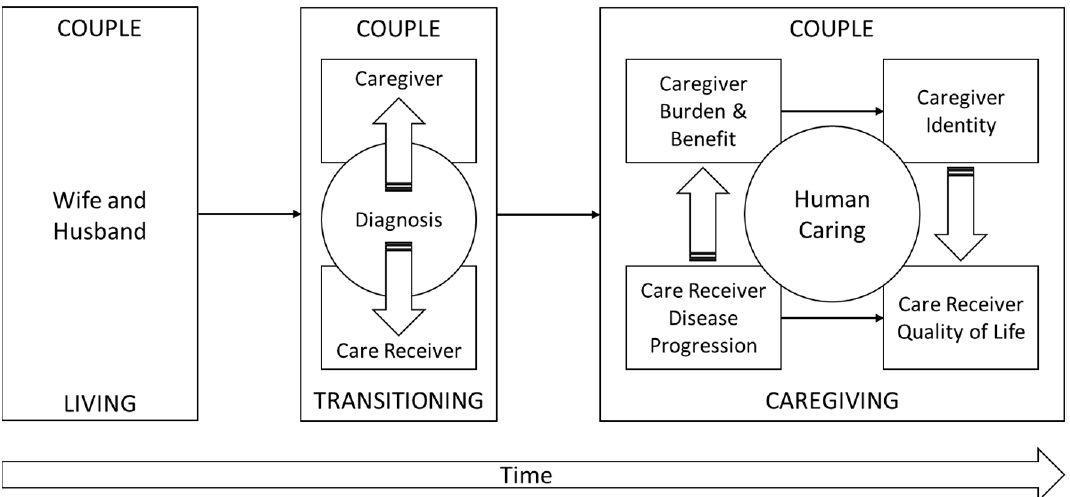
Figure 1. Conceptual Framework for Caregiver Transition in Parkinson’s Disease.